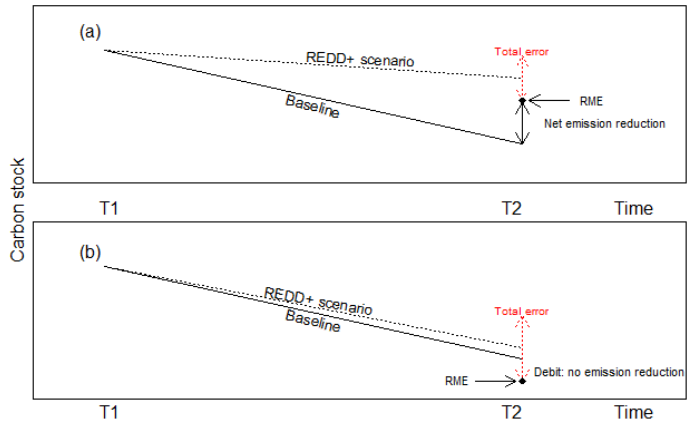
Figure 1. Projections of carbon emission under a business ‐ as ‐ usual baseline and a REDD+